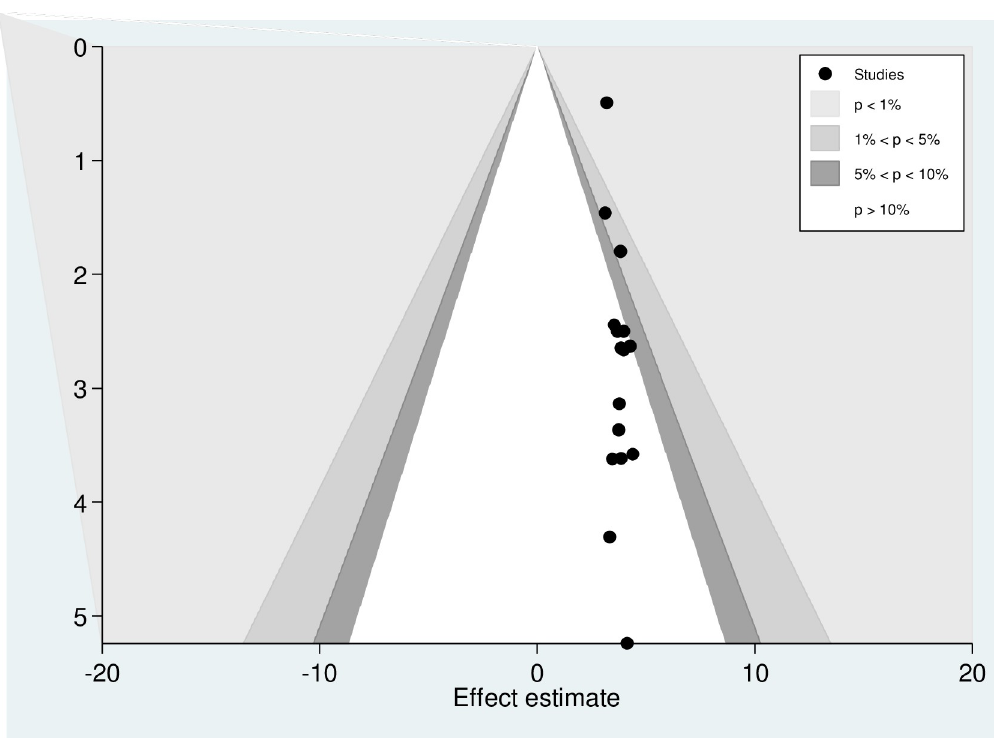
Fig 9. Counter-enhanced funnel plot suggestions of missing studies on the bottom left-hand-side of the plot. Since the majority of this area contains regions of high statistical significance ( P < 0.01), this reduces the plausibility that publication bias is the underlying cause of this funnel asymmetry. Various shaded regions indicate statistical significance. In particular, the white shaded region in the middle corresponds to p-values greater than .10, the dark gray-shaded region corresponds to p- values between .10 and .05, the medium gray-shaded region corresponds to p-values between .05 and .01, and the region outside of the funnel corresponds to p-values below